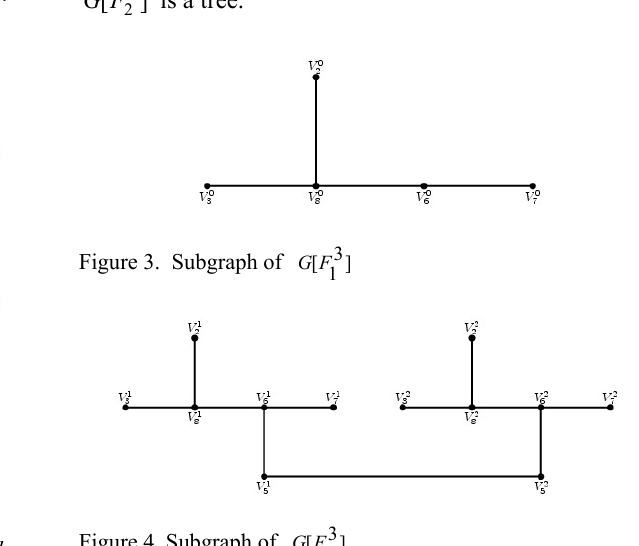
Figure 4. Subgraph